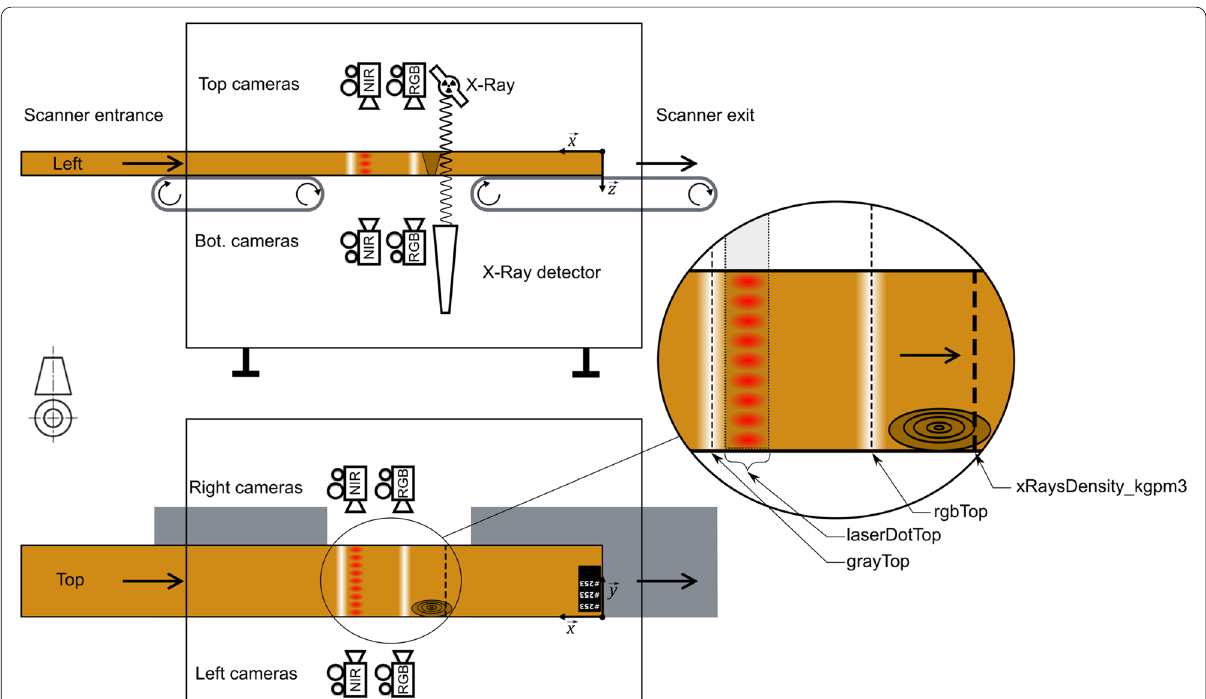
Fig. 9 Illustration of board scanning with side view on the top of the figure, and top view on the bottom of the figure, corresponding to left and top faces of the board, respectively. In the detail view, dashed lines represent a line of pixels which is recorded by the cameras while the board is conveyed longitudinally, and the grayed area with dotted line contour represents the region of interest used in the camera to treat ellipses